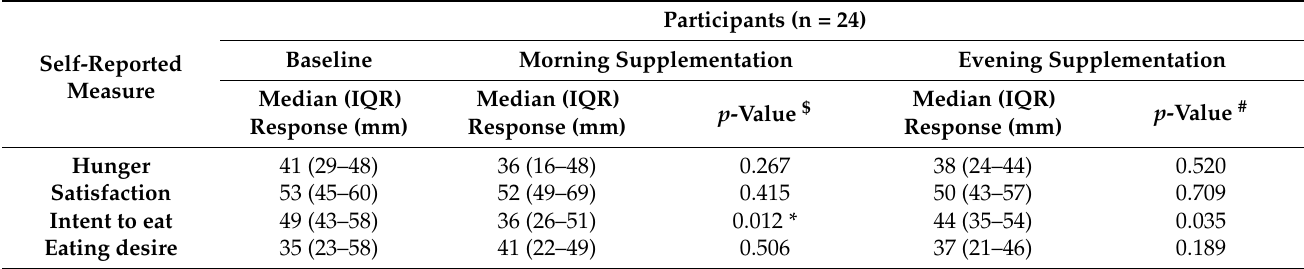
Table 1. Median (IQR) measured responses in mm to VAS questionnaires (0–100 mm) about self-reported feelings of hunger and appetite for all participants.